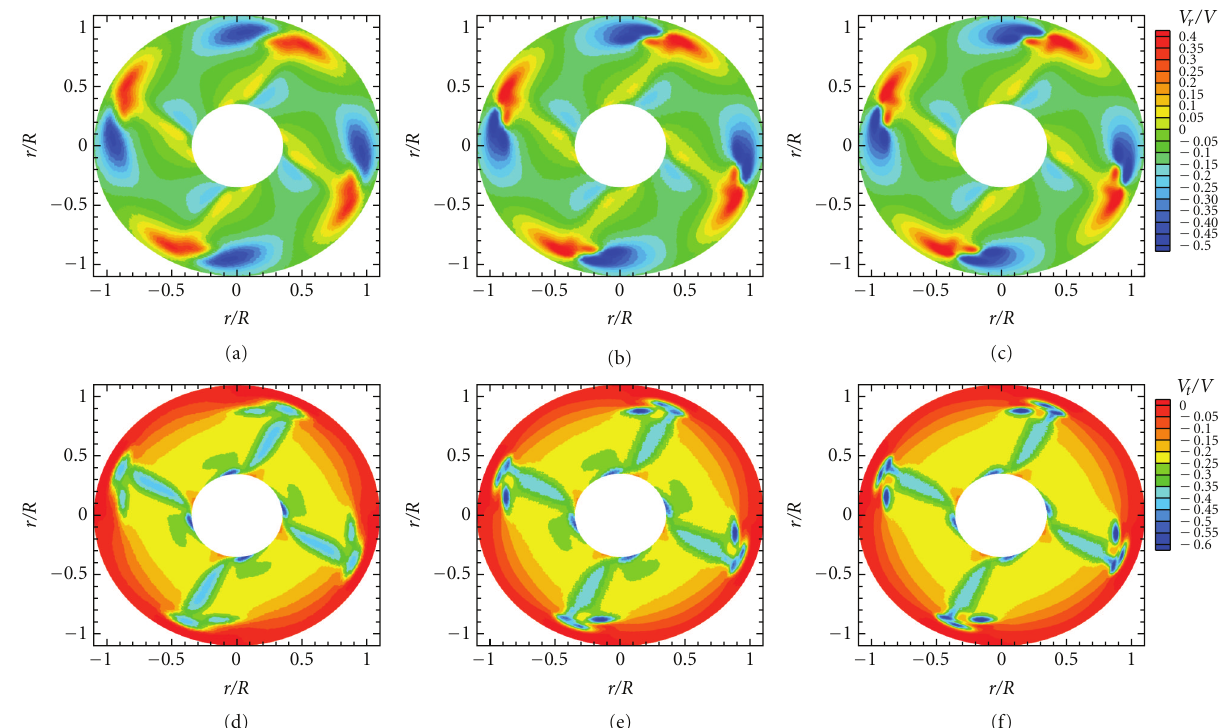
Figure 8: Convergence of radial and tangential nondimensional velocity distribution at x/R = 0 . 56 aft the propeller plane. ((a) and (d)) Base mesh. ((b) and (e)) Medium mesh. ((c) and (f)) Finer mesh.